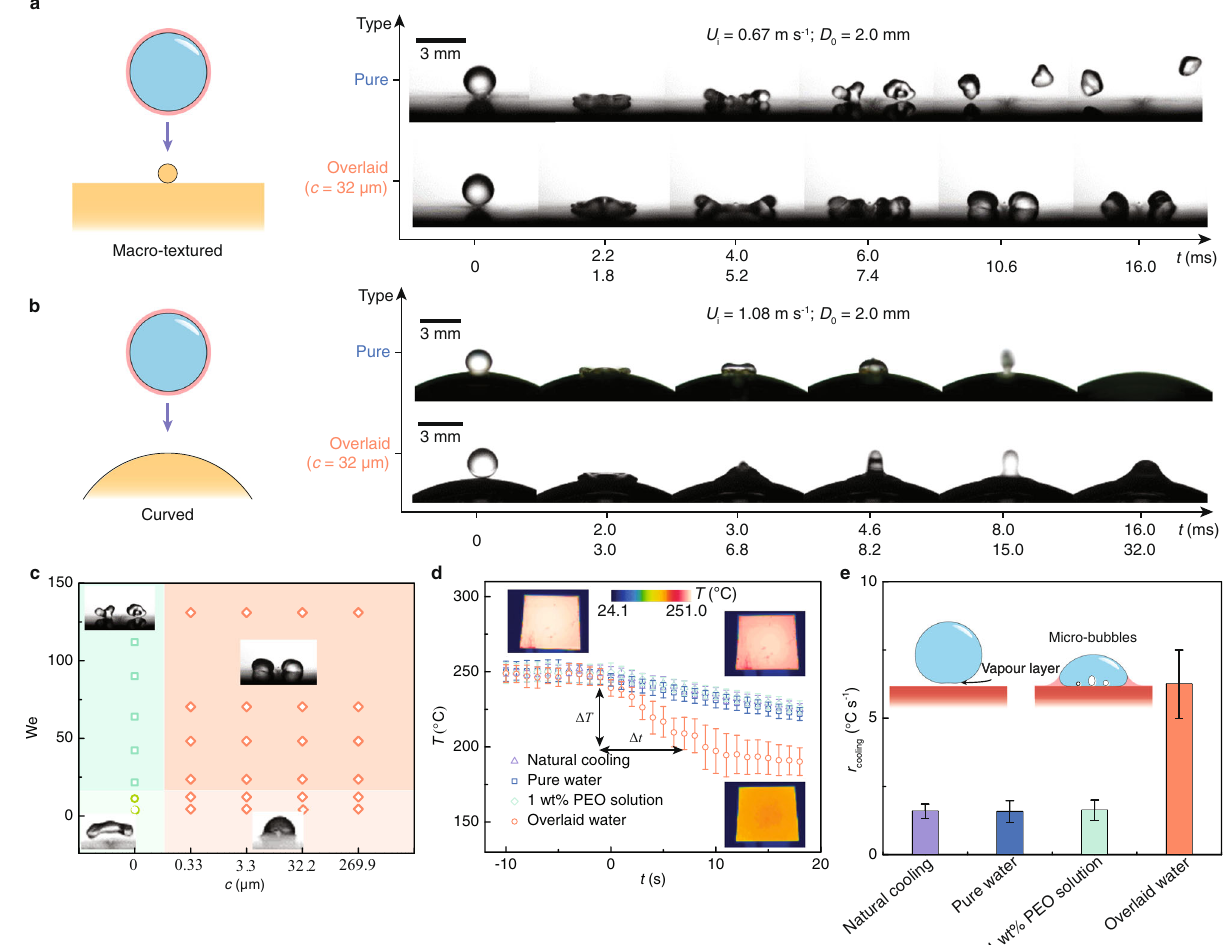
Fig. 4 Counteract topological perturbations. Sequential images showing dynamic impacts of water droplets on ( a ) macrotextured (We pure = 12.5, We overlaid = 22.5) and ( b ) curved (We pure = 32.5, We overlaid = 58.5) superhydrophobic surfaces. The overlayers thwart the two rebound upgrading mechanisms. c The phase diagram maps the impacting outcomes of the scenario in ( a ). The insets are the microscope images showing droplets after impacts in different phases. The green and red regions denote rebounding and deposited states, respectively. d Temperature evolution of superheated aluminium plates using different water cooling strategies. The overlaid water expedites the cooling. The insets are infrared thermal images of aluminium plates in cooling. Error bars denote the standard deviation over fi ve experiments. e Comparison of the cooling rates in the initial 8 s. Insets are schematics of the cooling mechanisms. Error bars denote the standard deviation over fi ve